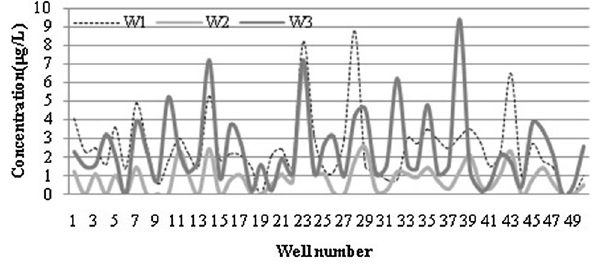
Fig. 3 Arsenic-content ( l g/L) of the shallow wells in the wet seasons ( W1 , W2 and W3 )